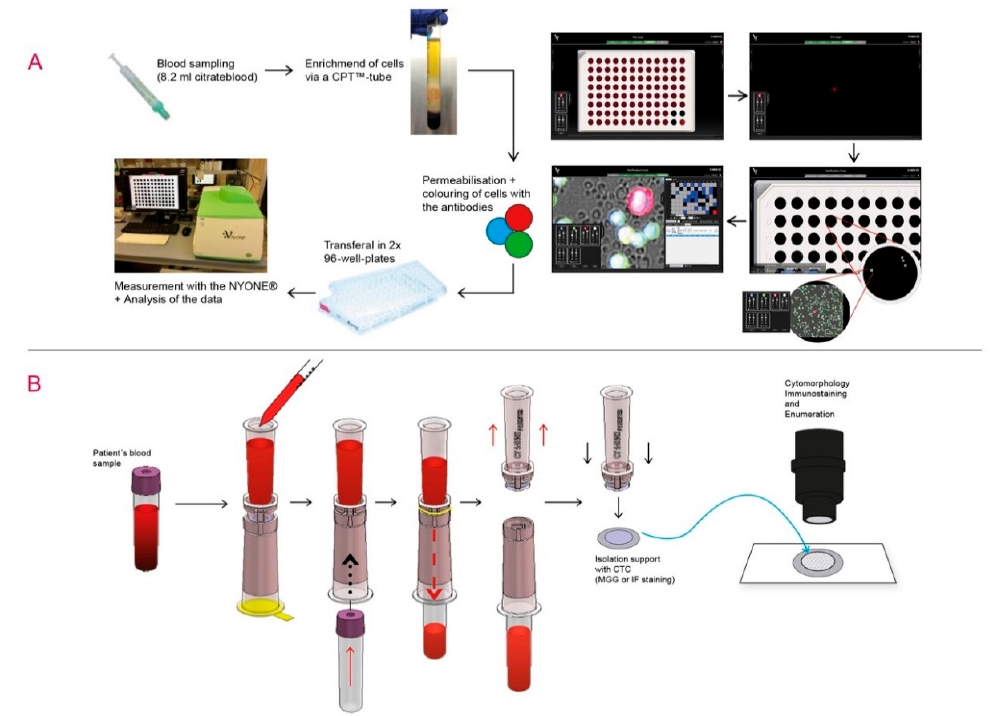
Figure 5 . Experimental set-up for CTC detection using NYONE ® and ScreenCell ® technology. ( A ) Figure 5. Experimental set-up for CTC detection using NYONE ® and ScreenCell ®